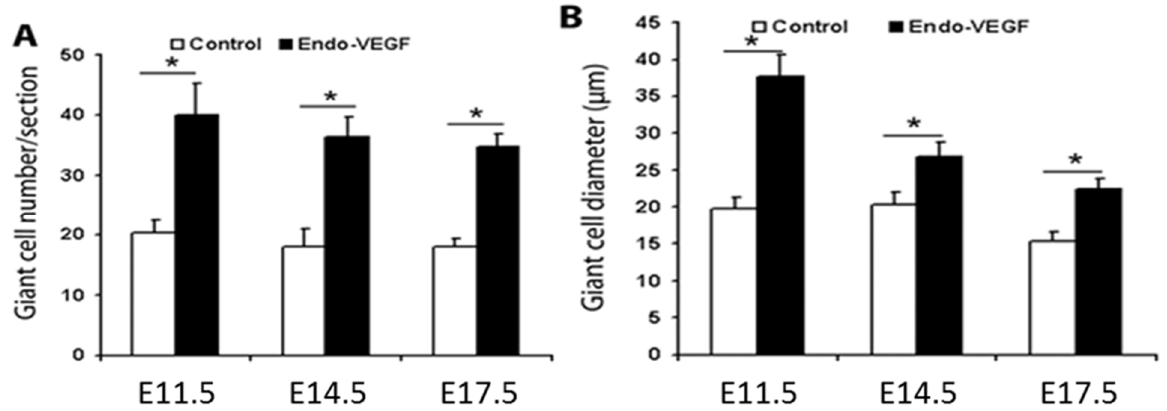
Figure 3. Increased number and size of TGCs in endometrial VEGF-overexpressing dams. Quantitative analysis of TGC number ( A ) and size (diameter, B ) at E11.5, E14.5, and E17.5. Mean number of TGCs measured from control placentas (white bars) and placentas derived from endometrial VEGF-overexpressing dams (black bars) at E11.5, E14.5, and E17.5. Error bars indicate standard deviation. Asterisks (*) denote statistically significant differences between groups ( p < 0.05). n = 10 placentas taken from dams treated with lentiviruses expressing GFP (control) and those expressing VEGF (Endo- VEGF).